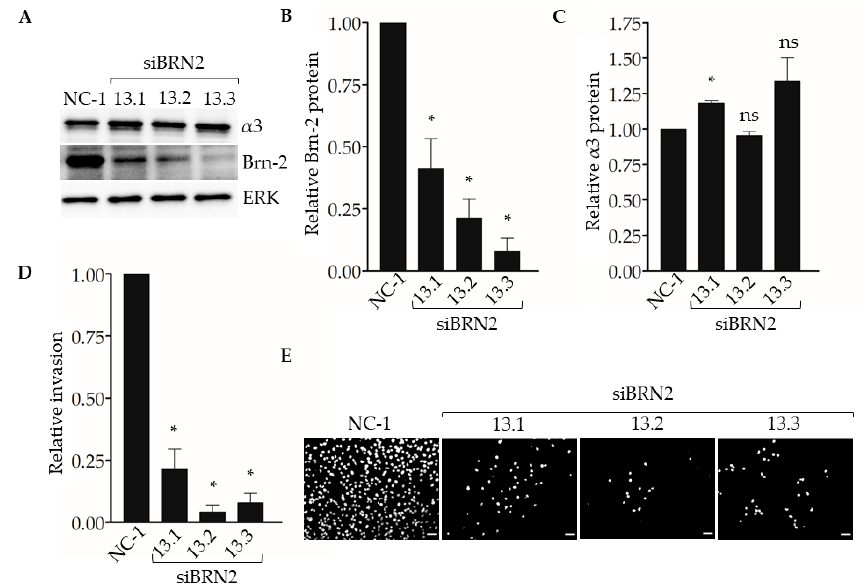
Figure 5. RNAi-targeting of BRN2 reduces MDA-MB-231 cell invasion. Matrigel transwell invasion assays were performed using MDA-MB-231 cells transfected with either non-targeting dicer-substrate siRNA (NC-1) or BRN2 -targeting dicer-substrate siRNA (si BRN2 13.1, 13.2, or 13.3). Nuclei were stained with DAPI, imaged, and quantified. ( A ) Representative Western blots for Brn-2, integrin α 3, and ERK (loading control); results for Brn-2 and α 3 are quantified in ( B ) and ( C ), respectively. ( D ) Graph shows invasion of Brn-2 knockdown cells relative to control cells; n = 3; mean +/ − SEM; * p < 0.05; two-tailed T -test with Bonferroni correction. ( E ) Representative images of DAPI-stained cells that invaded the undersides of transwell filters. Scale bar, 100 µm.